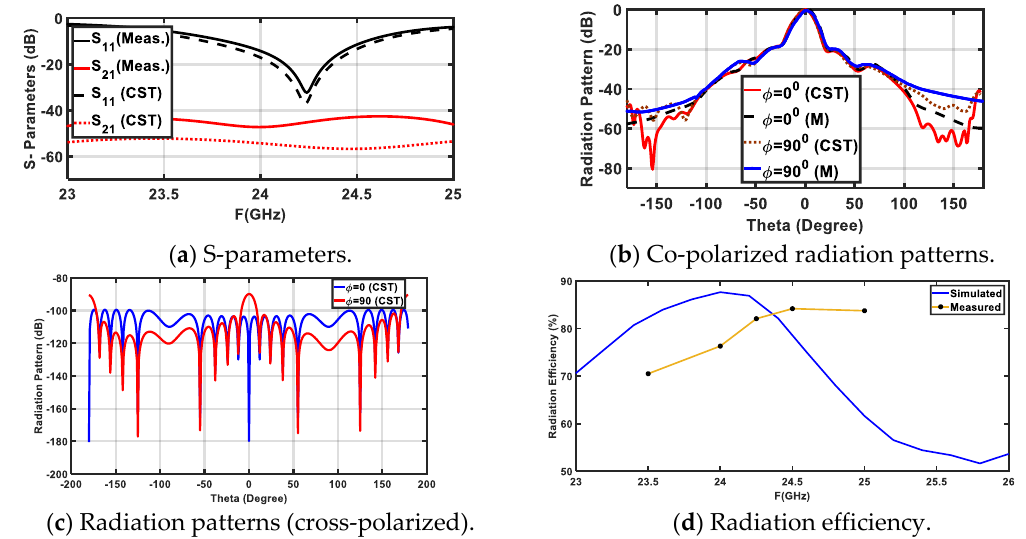
Figure 8. Simulated and measured results of VAA.